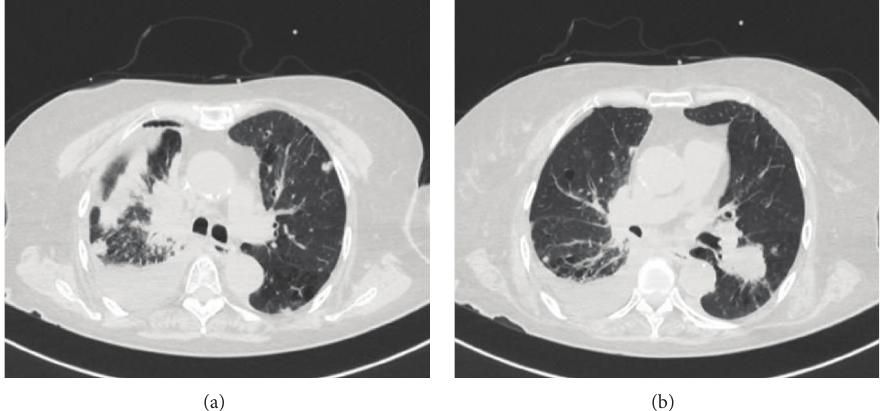
Figure 2: Chest CT scan demonstrated multiple tumors in the bilateral lungs and a right-sided pleural effusion.